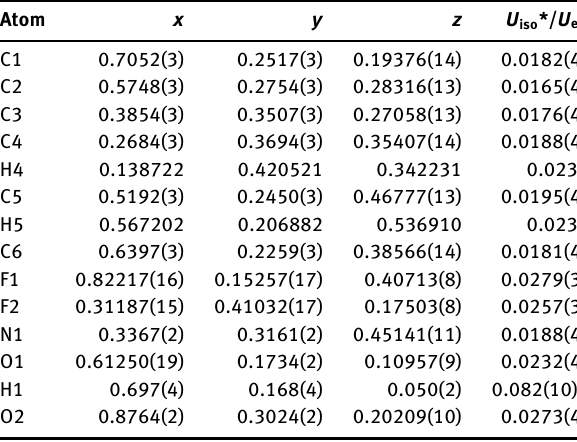
Table 2: Fractional atomic coordinates and isotropic or equivalent isotropic displacement parameters (Å 2